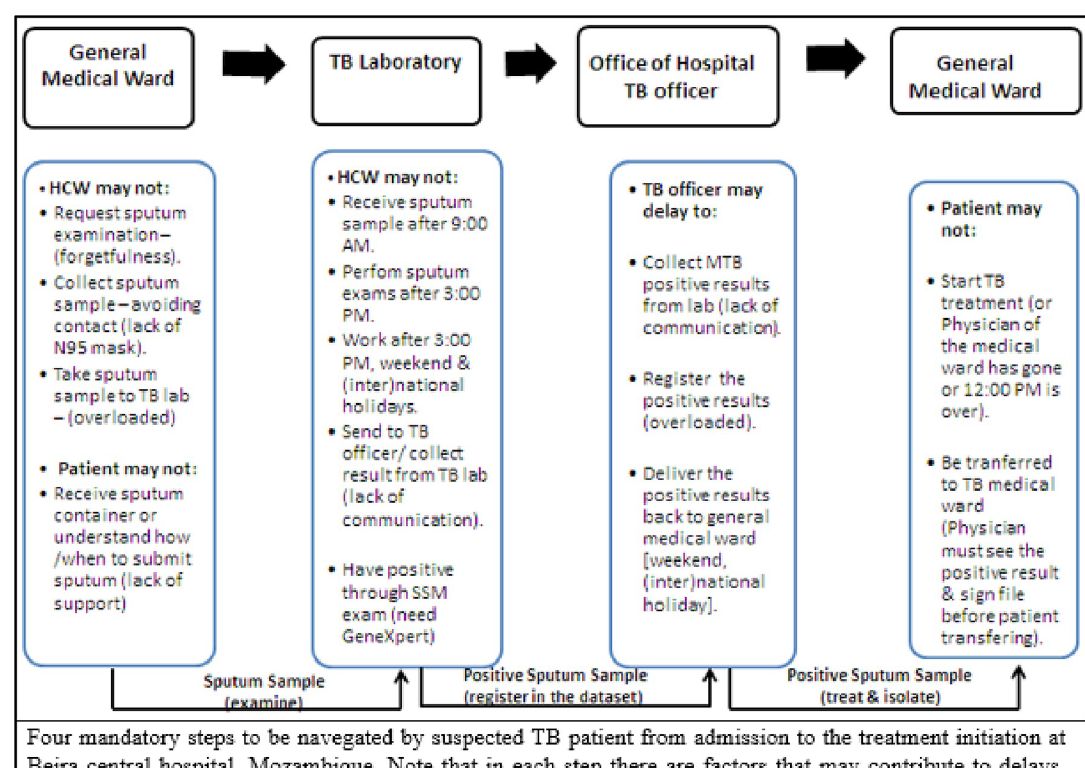
Fig 1. Current steps and perceived factors associated with in-hospital delays to TB diagnostic and treatment in Beira, Mozambique,